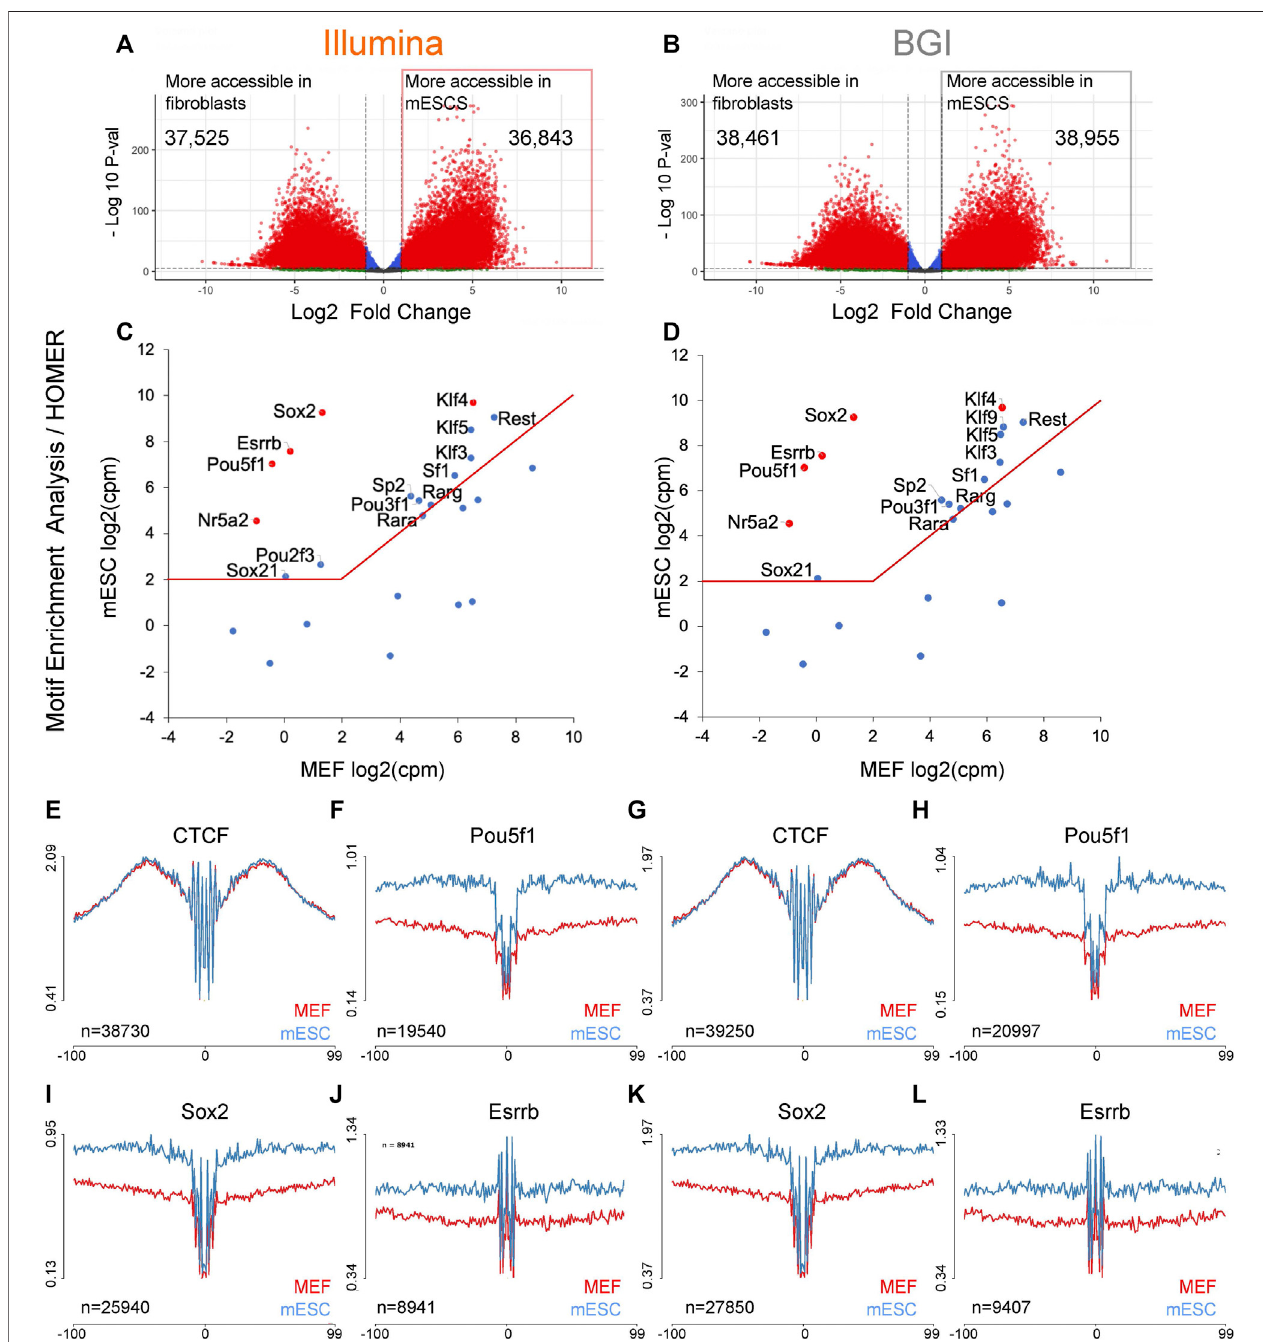
FIGURE 3 | Motif enrichment analysis to recover TF that underpins the mESC identity. (A,B) Volcano plots for differentially accessible peaks between MEFs and mESCs were identi fi ed for data from both platforms ( n = 3 biological replicates). (C,D) The top 25 motifs identi fi ed by HOMER with higher enrichment in mESC speci fi c regionswereintegratedwithtranscriptionaldataformESCsandMEFs( n =3biologicalreplicates)tovisualizeexpressiondifferencesoflinkedTFsacrossbothcelltypes. Thetop fi vemotifs(re-rankedbyexpressiondifferences)areindicatedinred.Bothdatasetsrecoveredthesame fi veTF(indicatedinred)containingthreepublished 3-factor combinations previously demonstrated to enable pluripotency induction (Pou5f1, Sox2, Klf4; Pou5f1, Esrrb, Klf4, Nr5a2, Sox2, Klf4). (E – L) Aggregate TF footprint pro fi les for CTCF, Pou5f1, Sox2, and Esrrb for both Illumina and BGI ATACseq data sets (pro fi les are based on the merged data of three biological replicates). The number of TFBS used to generate each aggregate is indicated in the bottom left corner of each plot and is based on PMW scanned sites that intersect with a sample ’ s open chromatin regions.